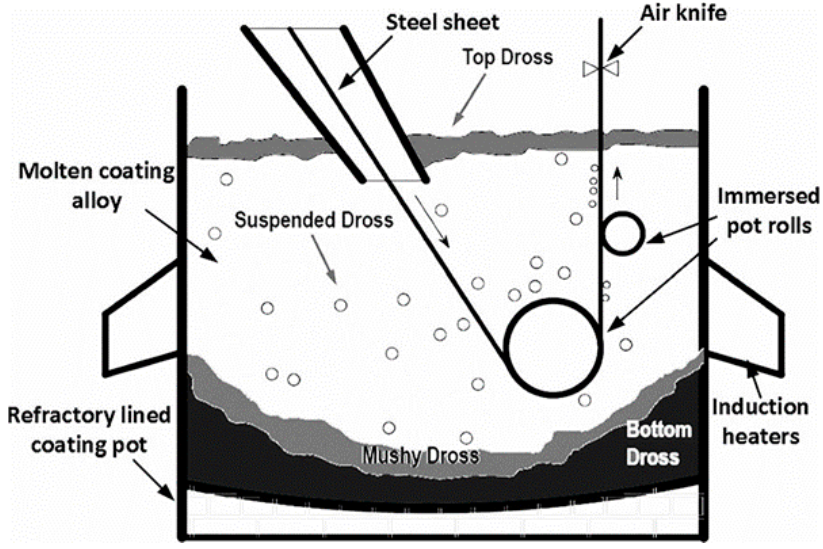
Figure 1. A schematic presentation of continuous hot-dip galvanizing process [2].